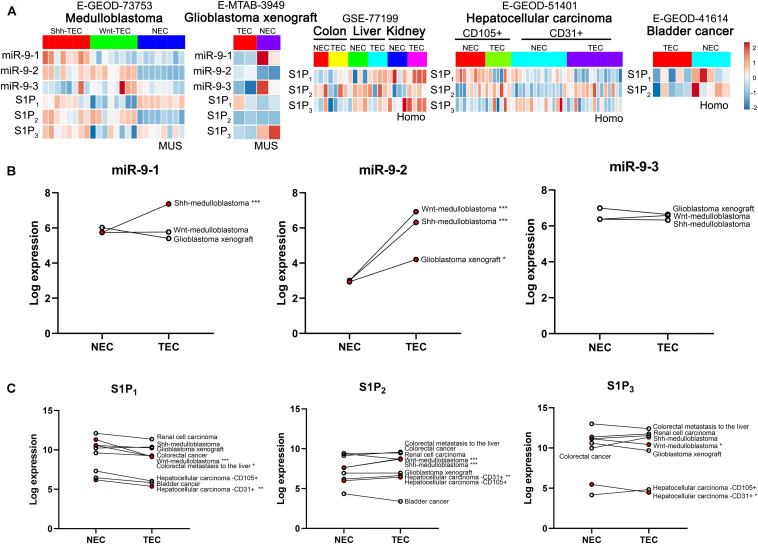
Expression analysis of miR-9 and S1P receptors in tumor ECs and normal ECs basing on EndoDB databases. (A) Gene expression heatmap of normal ECs (NEC) vs. tumor ECs (TEC). Red indicates high-expression levels, and blue indicates low-expression levels. (B) Expression of the miR-9-1, miR-9-2, and miR-9-3 in NECs and TECs. MUS: musculus; Homo: Homo sapiens. *P < 0.05, **P < 0.01, ***P < 0.001.